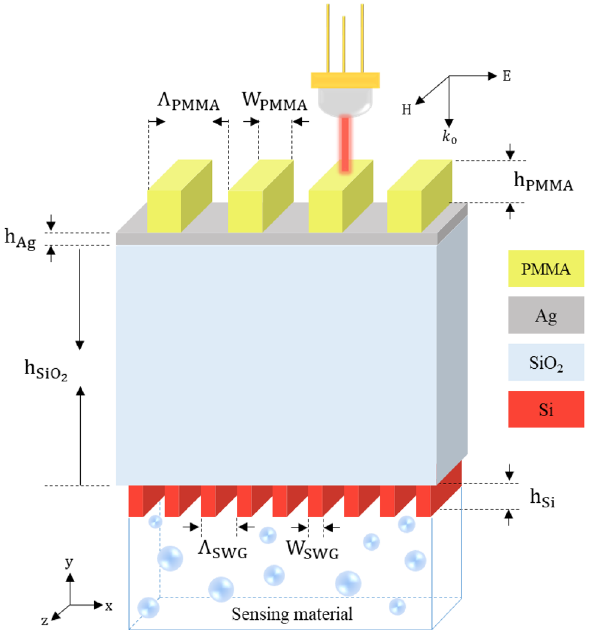
Figure 1. Schematic configuration of the proposed plasmonic